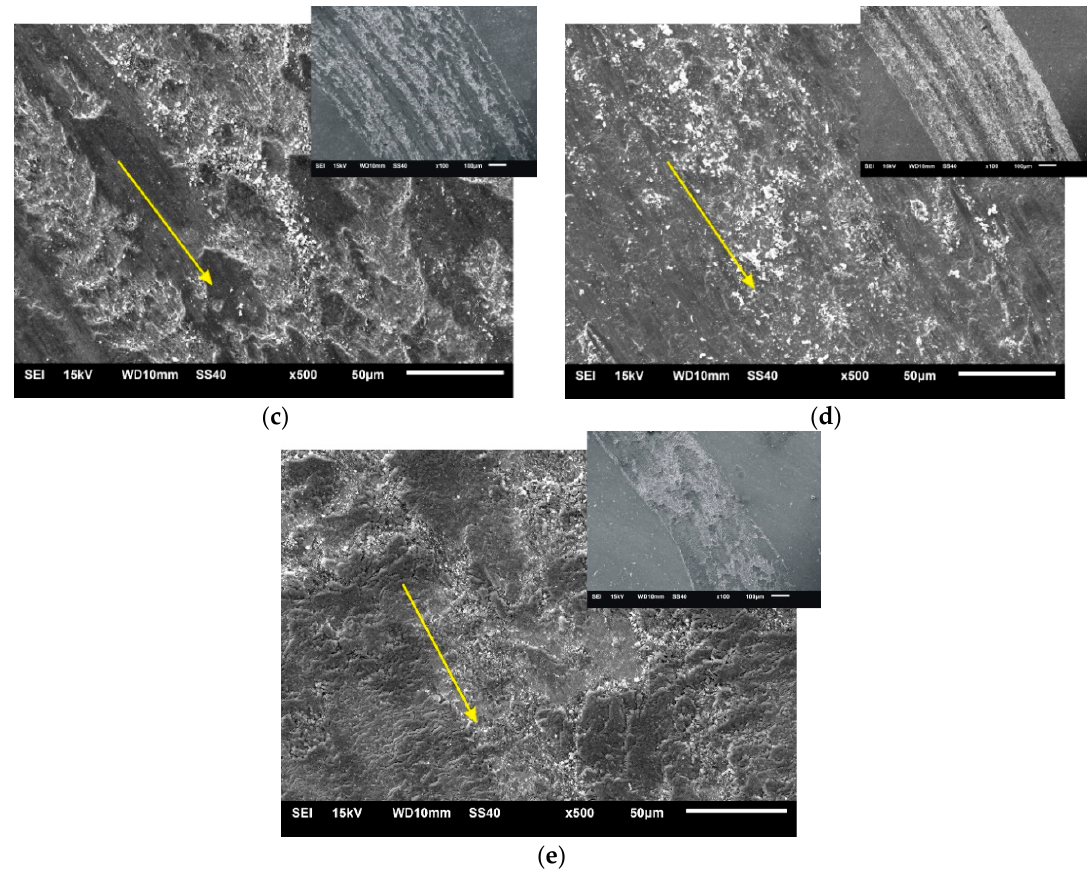
Figure 13. Worn surfaces after the wear test with applied Al 2 O 3 ball for: ( a ) 316L steel, and ( b ) steel + 5% ZrB 2 , ( c ) steel + 10% ZrB 2 ( d ) steel + 15% ZrB 2 and ( e ) steel + 20% ZrB 2 composites.